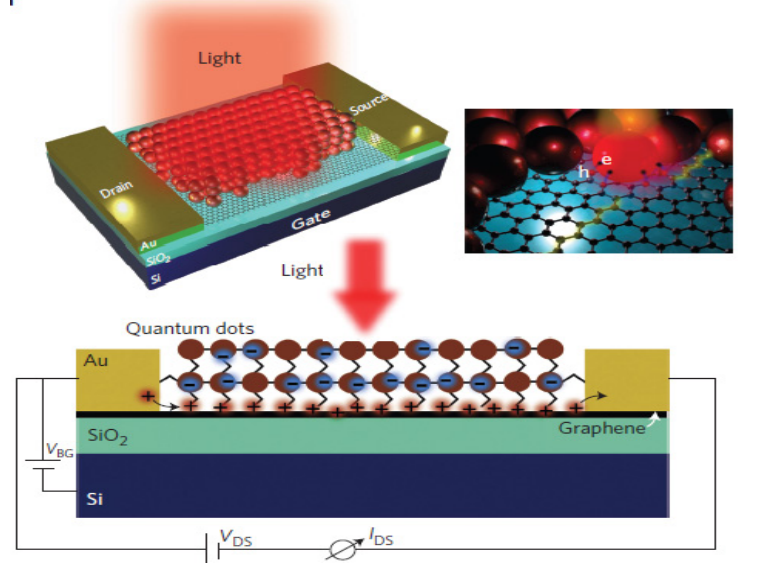
Figure 9. Scheme the hybrid G/PbS phototransistor. Reprinted with copyright permission from reference [139]. Copyright © 2012, Nature Publishing